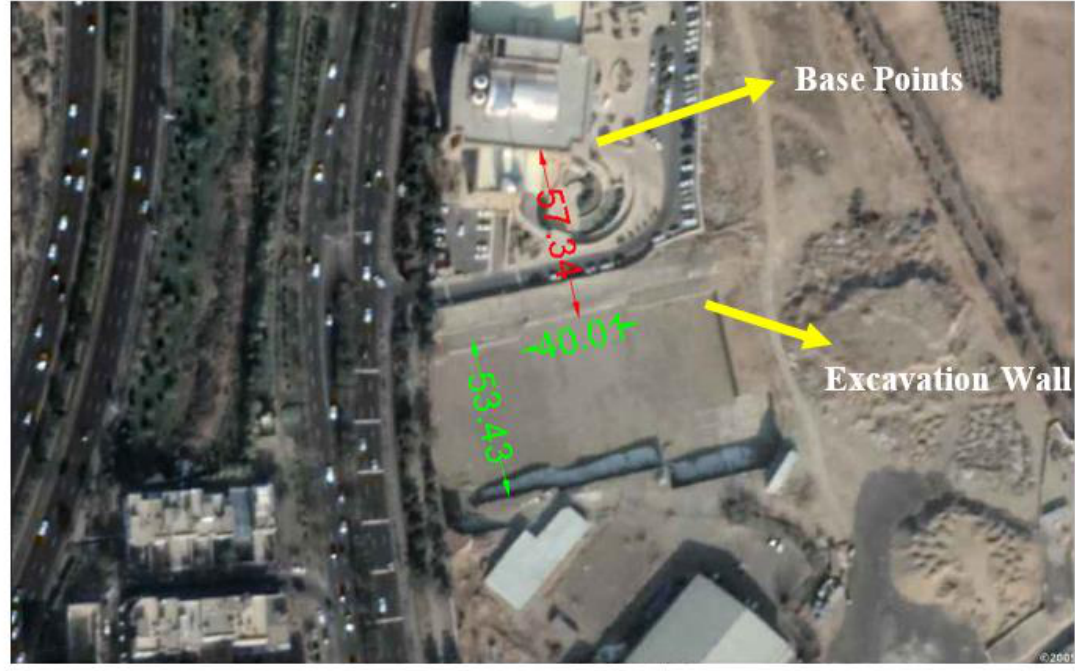
Figure 10. The excavation area and its dimensions.